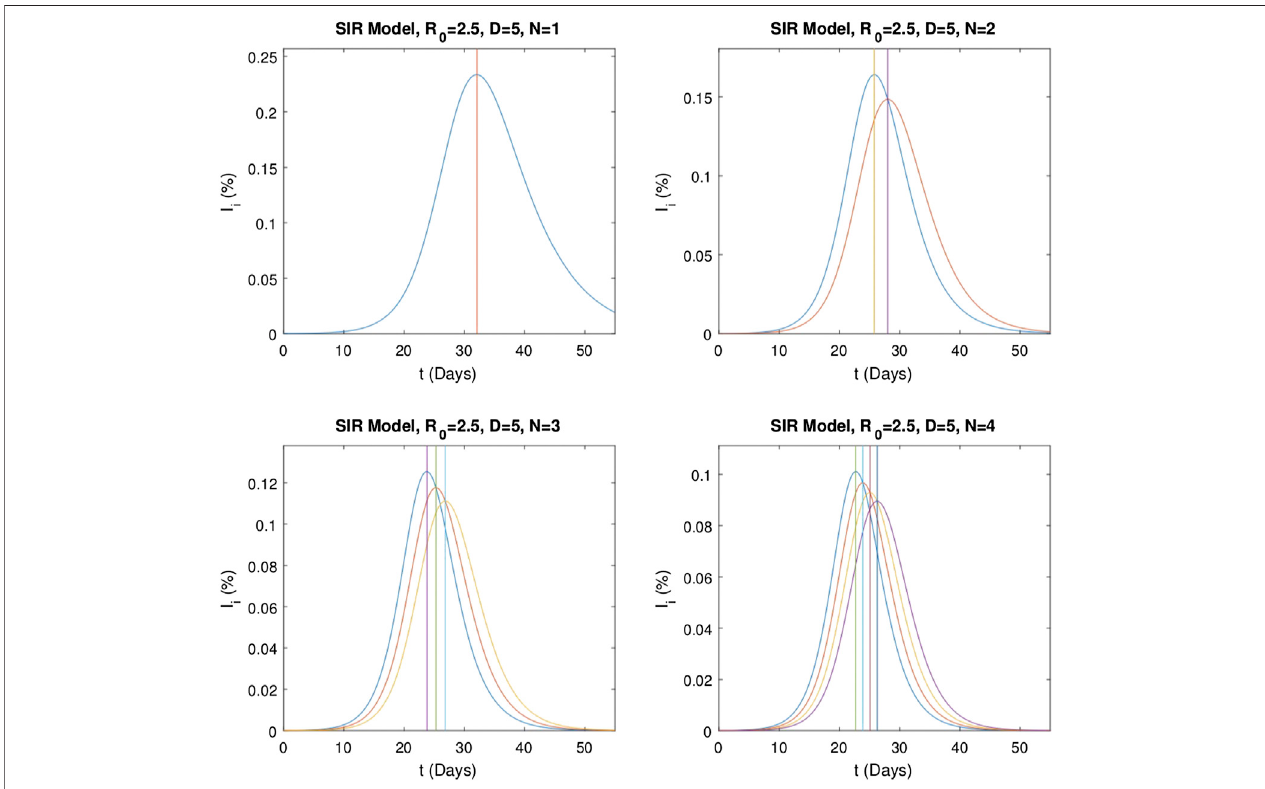
FIGURE 7 | Graphs of the independent infectious stages I 0 , ... I N from numerical solutions of the multistage SIR model (5). Here, R 0 (cid:2) 2 . 5 and c (cid:2) 0 . 2 × N . In the graphs, vertical lines indicate the position of maximum points of the independent infectious stages. The distance between these vertical lines is approximately 1 / c .